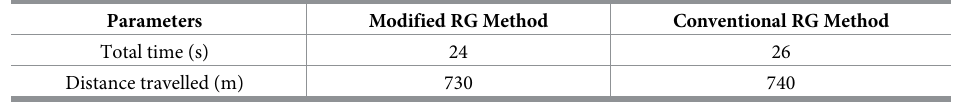
Table 5. Comparison of time and distance in scenario 3.